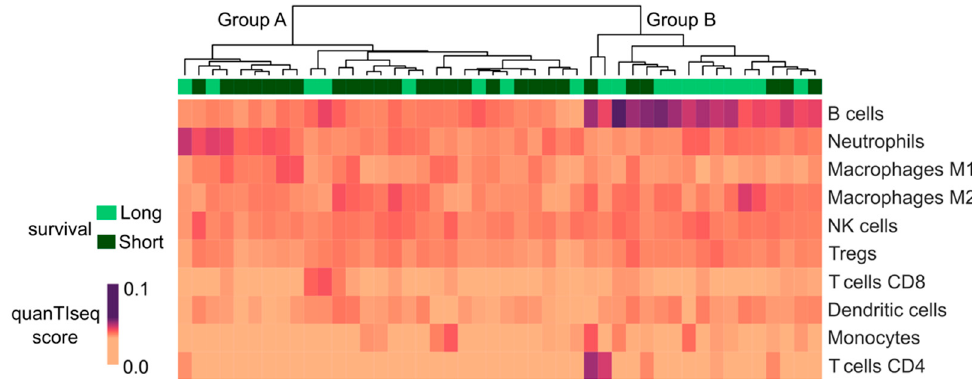
Figure 2. Evaluation of immune infiltrating cells through the quanTIseq deconvolution approach. From the top downwards: unsupervised clustering of the ePM cohort divided into Group A and Group B. The green line represents survival: long survivors in light green; short survivors in dark green. The heatmap shows the quanTIseq score through a range of colors as in the legend: the darker the color, the higher the